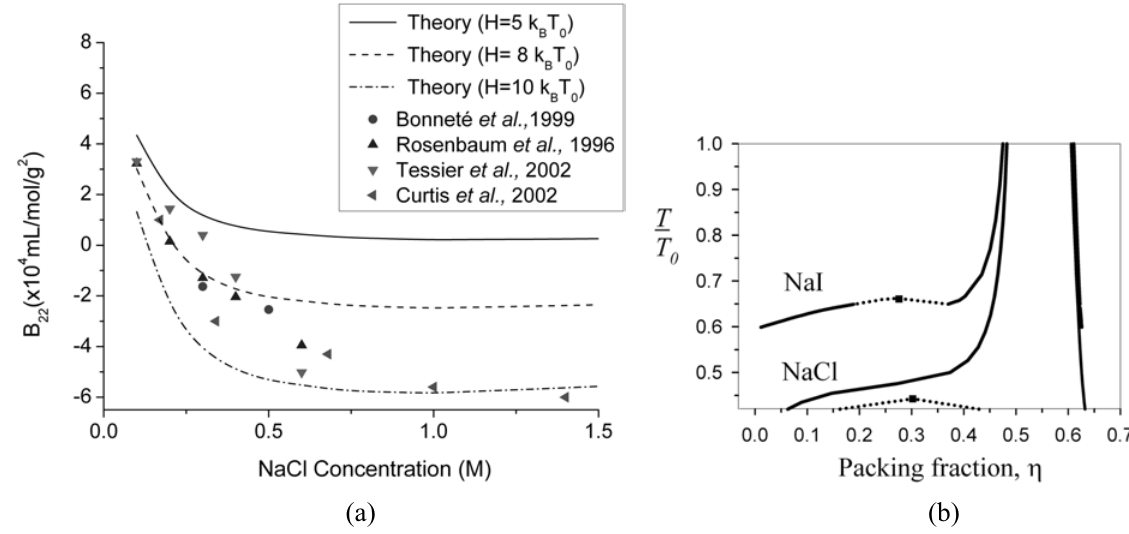
Fig. 7 – (a) Comparison of the theoretical second virial coefficient for lysozyme- lysozyme interactions (for three values of the Hamaker constant equal to 5 k B T 0 , 8 k B T 0 and 10 k B T 0 ) in NaCl solution at pH 4.5 with experimental data; (b) Phase diagrams for two aqueous lysozyme solutions containing NaCl or NaI. For all cases, salt concentration is 0.3 M and T 0 is 298K. Stable fluid-fluid (dashed line) and fluid-solid (solid lines) transitions appear for solutions containing NaI. When the electrolyte is NaCl, the stable transition is fluid-solid for all packing fractions. The metastable fluid-fluid transition for NaCl is represented by a dashed line. Symbols (squares) are fluid-fluid critical points. (Lima et al. 2007c,